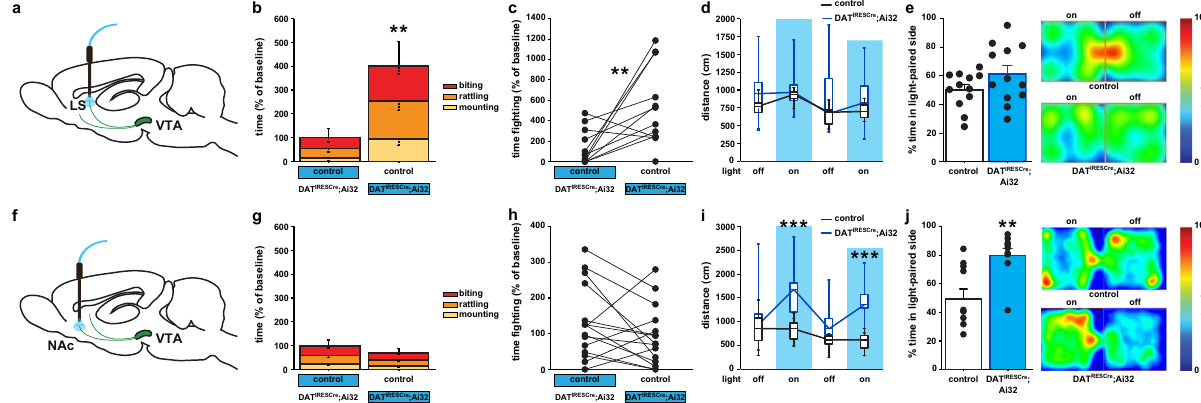
Fig. 3 DAergic projections to the LS, not NAc, promote aggression. a , f Schematic diagrams for terminal stimulation in vivo. b , c Heightened aggressive behavior was observed in pairs when DAT IRESCre ; Ai32 mutant mice were stimulated (blue) in LS DA terminals. No effect of LS stimulation was detected in locomotor activity in the d open fi eld or e real-time place preference (RTPP). g , h Aggressive behavior was not altered with NAc DA terminal stimulation (blue). i DA terminal stimulation in the NAc increased locomotor activity in the open fi eld, during alternating 3 min off and on bouts of 20 Hz stimulation only in DAT IRESCre ; Ai32 mutant mice. j The percentage of the time, over a 20 min session, spent in the stimulated zone during RTPP was signi fi cantly increased following stimulation in mutants. Also shown representative heat maps of the time spent in the stimulated zone of the chamber during RTPP. ** P < 0.01; *** P < 0.001 compared with their respective controls; mean ± SEM; n = 16 pairs ( b , c ), 8 – 9/group ( d ), 12/group ( e ), 20 pairs ( g , h ) and 20/ group ( i , j ), box plots represent median and IQR and whiskers extend to maximum and minimum values ( d , i